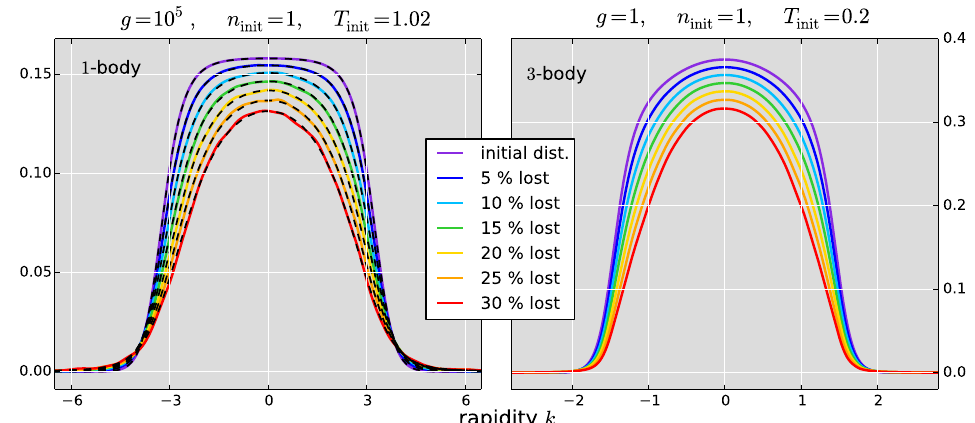
Figure 4: Evolution of the rapidity distribution under atom losses. Left: one-body losses in the hard-core regime. The initial state is the same as in Fig. 3. To benchmark our method we compare our numerical results with the analytical formula (15) (black dashed line): the agreement is excellent. Right: three-body losses, away from the hard-core regime. The initial state is the same as in Fig.